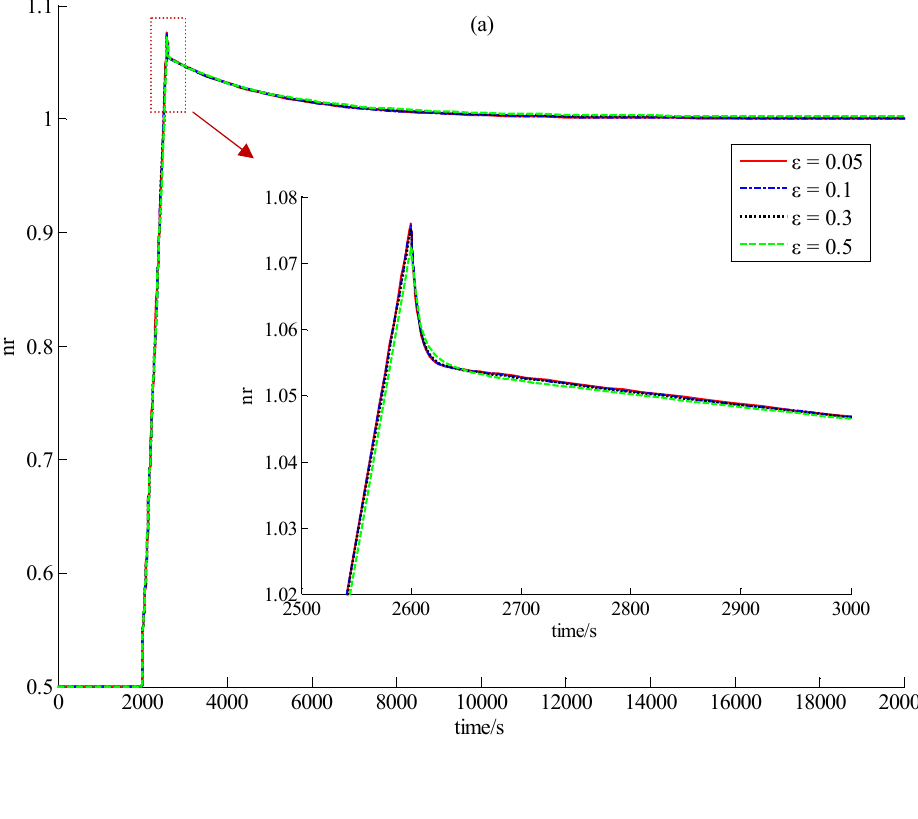
Figure 6. Dynamic responses in Case B of ( a ) relative nuclear power; ( b ) average fuel temperature; ( c ) outlet helium temperature and ( d ) control rod speed signal with constant σ and different ε